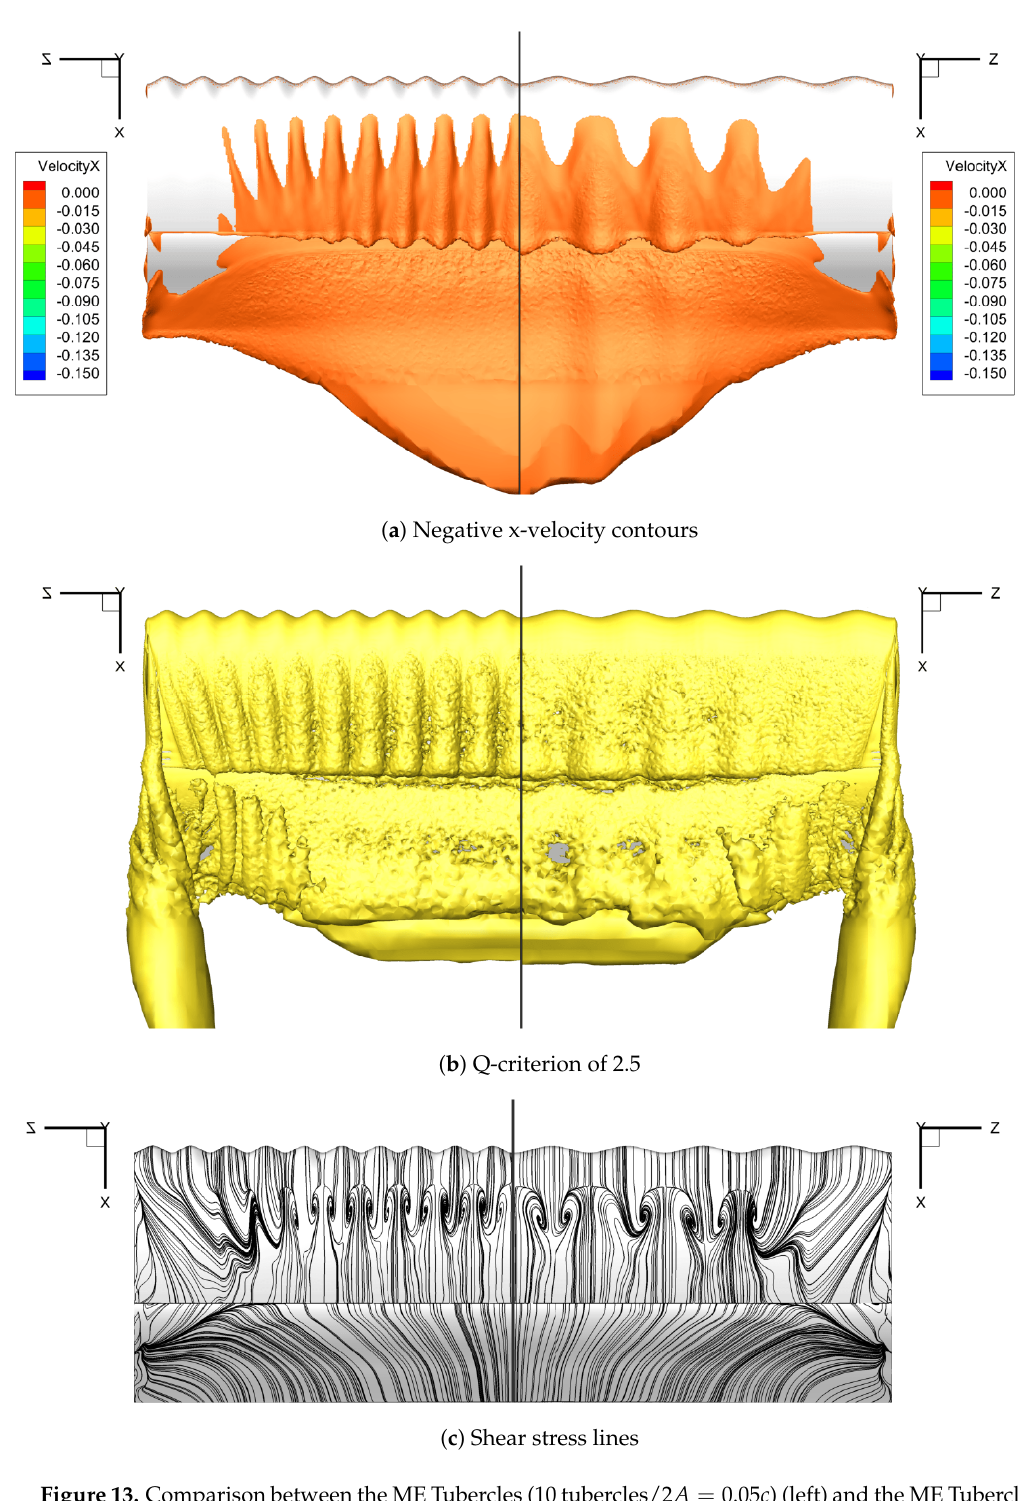
Figure 13. Comparison between the ME Tubercles (10 tubercles/2 A = 0.05 c ) (left) and the ME Tubercles (5 tubercles/2 A = 0.05 c ) (right) geometries. The geometries are seen from below and slightly from behind. The main element is at the top and the flap at the bottom. The flow is going from the top to the